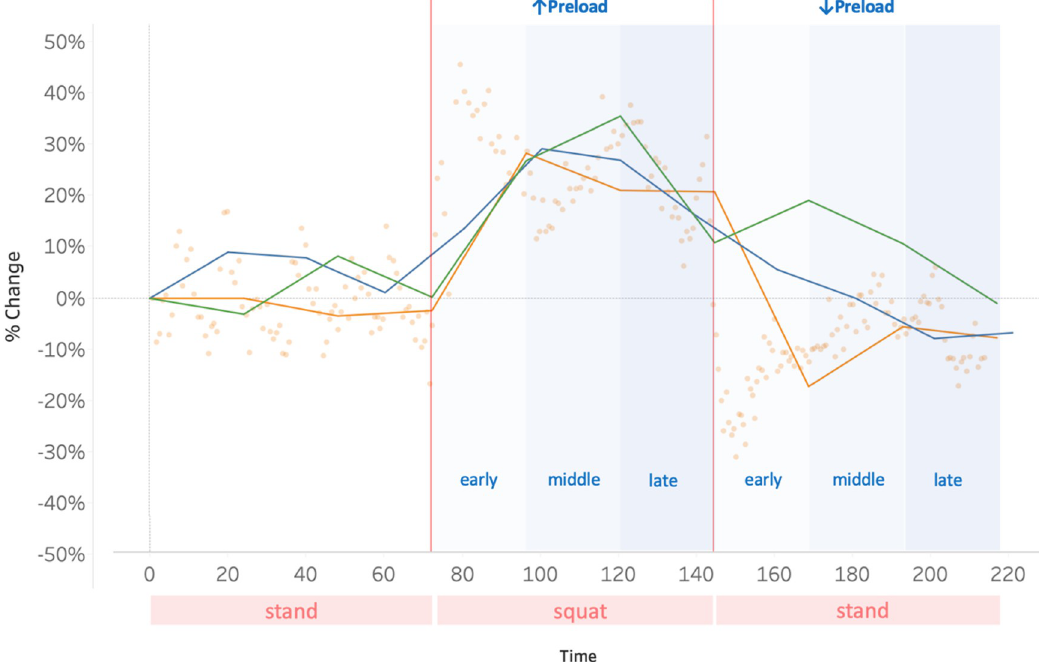
Fig 2. Representative protocol. Orange dots represent single beat VTI from the wearable carotid Doppler while the orange line depicts 24-second averages of the VTI. Green line is the 24-second average of SV from bioreactance. The blue line is a 20-second SV from non-invasive pulse contour. Y-axis is % change for each metric and x-axis is time.